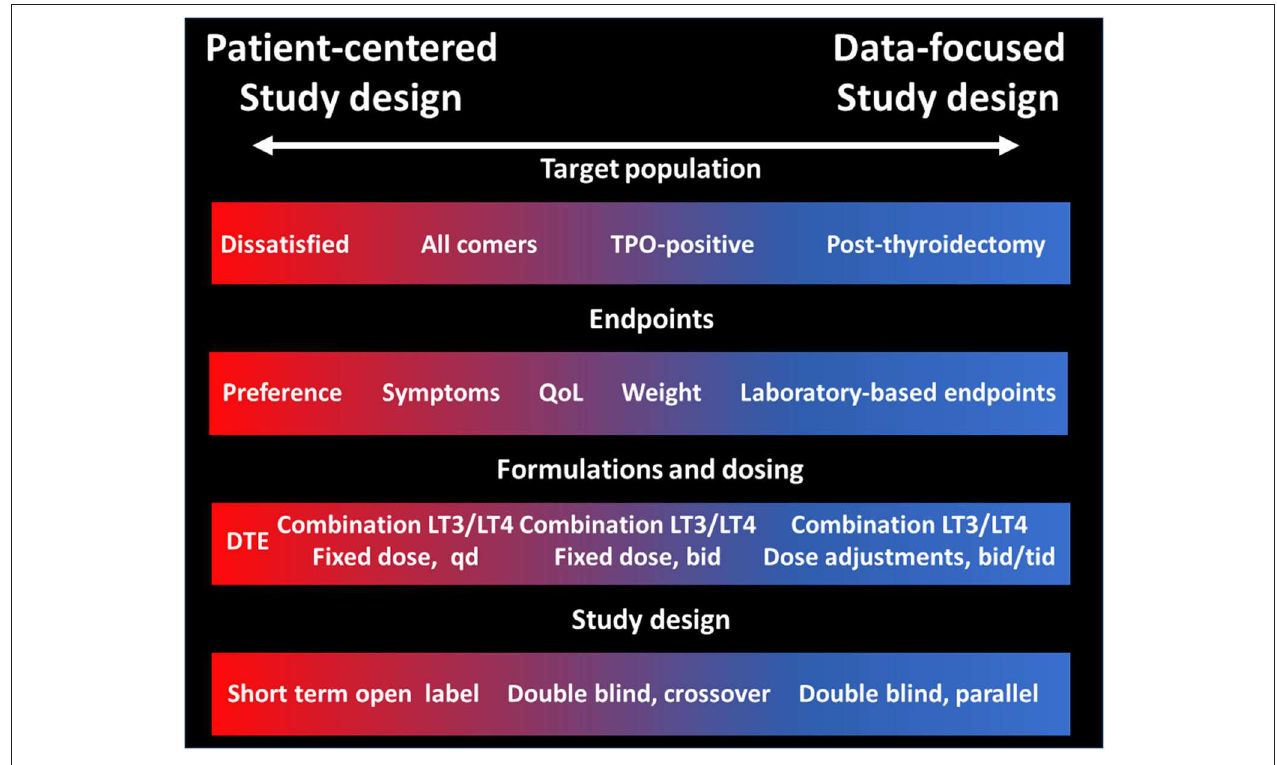
FIGURE 1 | Tradeoffs in study design of LT3:LT4 combination therapy or DTE vs. LT4 alone for the treatment of hypothyroidism. Tradeoffs in four domains of a clinical trial directed to assess the efficacy and effectiveness of therapies other than LT4 alone vs. LT4. The left part of the panels (red) indicates choices more suitable for a patient-centered study, while the right side of the panels indicates choices more suitable for a data-focused